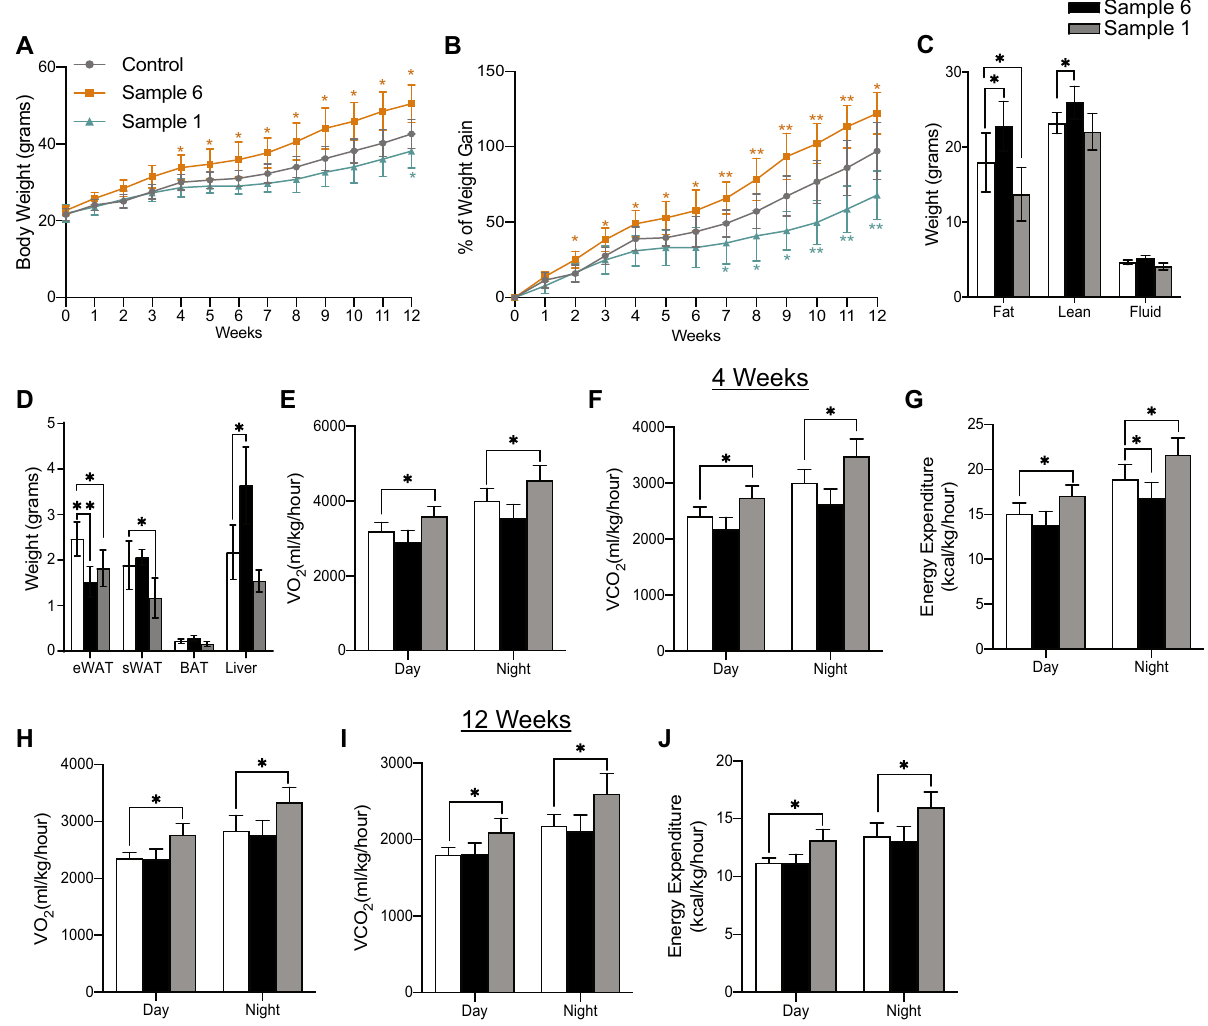
Figure 3. Treatment of mice with obesogenic diets supplemented with myriocin containing Cordyceps reduces body weight and increases energy expenditure. C57Bl6/J mice fed high fat diets supplemented with starch (control), Sample 1 and Sample 6 for 12-weeks. ( A ) Body mass and ( B ) Percentage weight gain was determined weekly. ( C ) Fat, lean and fluid mass were quantified by NMR and ( D ) organ weight was determined following euthanasia (N = 5–7 animals per group). Following 4-weeks ( E – G ) and 12-weeks ( H – J ) of dietary intervention supplemented with Cordyceps animals were placed in metabolic cages (CLAMS) from Columbus Instruments. During the subsequent 3-days, ( E , H ) oxygen consumption (VO 2 ), ( F , I ) carbon dioxide production (VCO 2 ) and ( G , J ) energy expenditure was quantified (N = 4–7 animals per group). Values are expressed as mean ± SEM, *p < 0.05, **p < 0.001, ***p < 0.0001 vs and chronic treatment with HFD-supplemented with myriocin containing Cordyceps extract selectively inhibit synthesis of sphingolipids and its precursor ceramide. Pharmacological and genetic inhibition of SPT presents with intestinal toxicity and alters intestinal morphology 51,52 . Therefore, we investigated whether treatment of mice with sample 1 Cordyceps extract had any impact on intestinal morphology. Histological analysis of the intestine following treatment with Cordyceps extracts from both sample 1 and sample 6 did not exhibit any alterations in gross intestinal morphology (Fig. 2G). Independent pathological assessment, further revealed no intestinal toxicity in animals treated with either sample 1 or sample 6 (Fig. 2G). Treatment of mice with myriocin containing Cordyceps increases energy expenditure in obese mice. Treatment of C57Bl6/J mice with HFD-supplemented with sample 1 reduced ~ 30% body weight (Fig. 3A,B) and altered lean/fat mass ratios (Fig. 3C), the phenotype that is consistent with our previous study following whole-body inhibition of SPT with the pharmacological agent myriocin 27 . In contrast, treatment with HFD-diet supplemented with sample 6, that lacks myriocin increased ~ 20% body weight and lean fat mass ratio (Fig. 3A–C). Consistent with reductions in fat mass observed, sample 1 treatment reduced weights of vari-